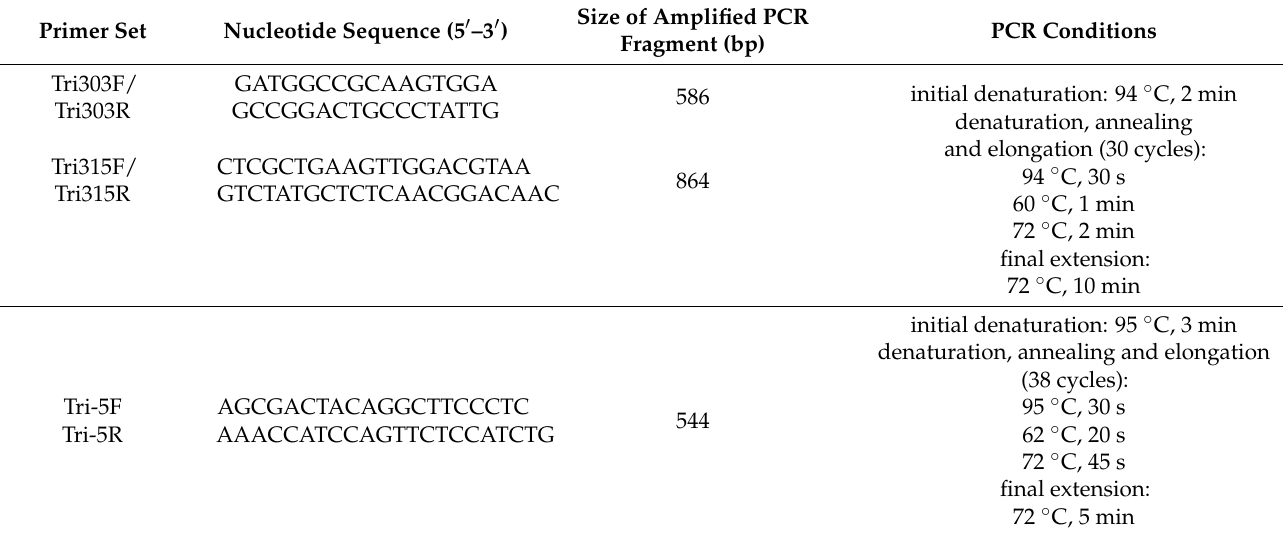
Table 2. Primer sets and PCR conditions for trichothecene genotyping of the